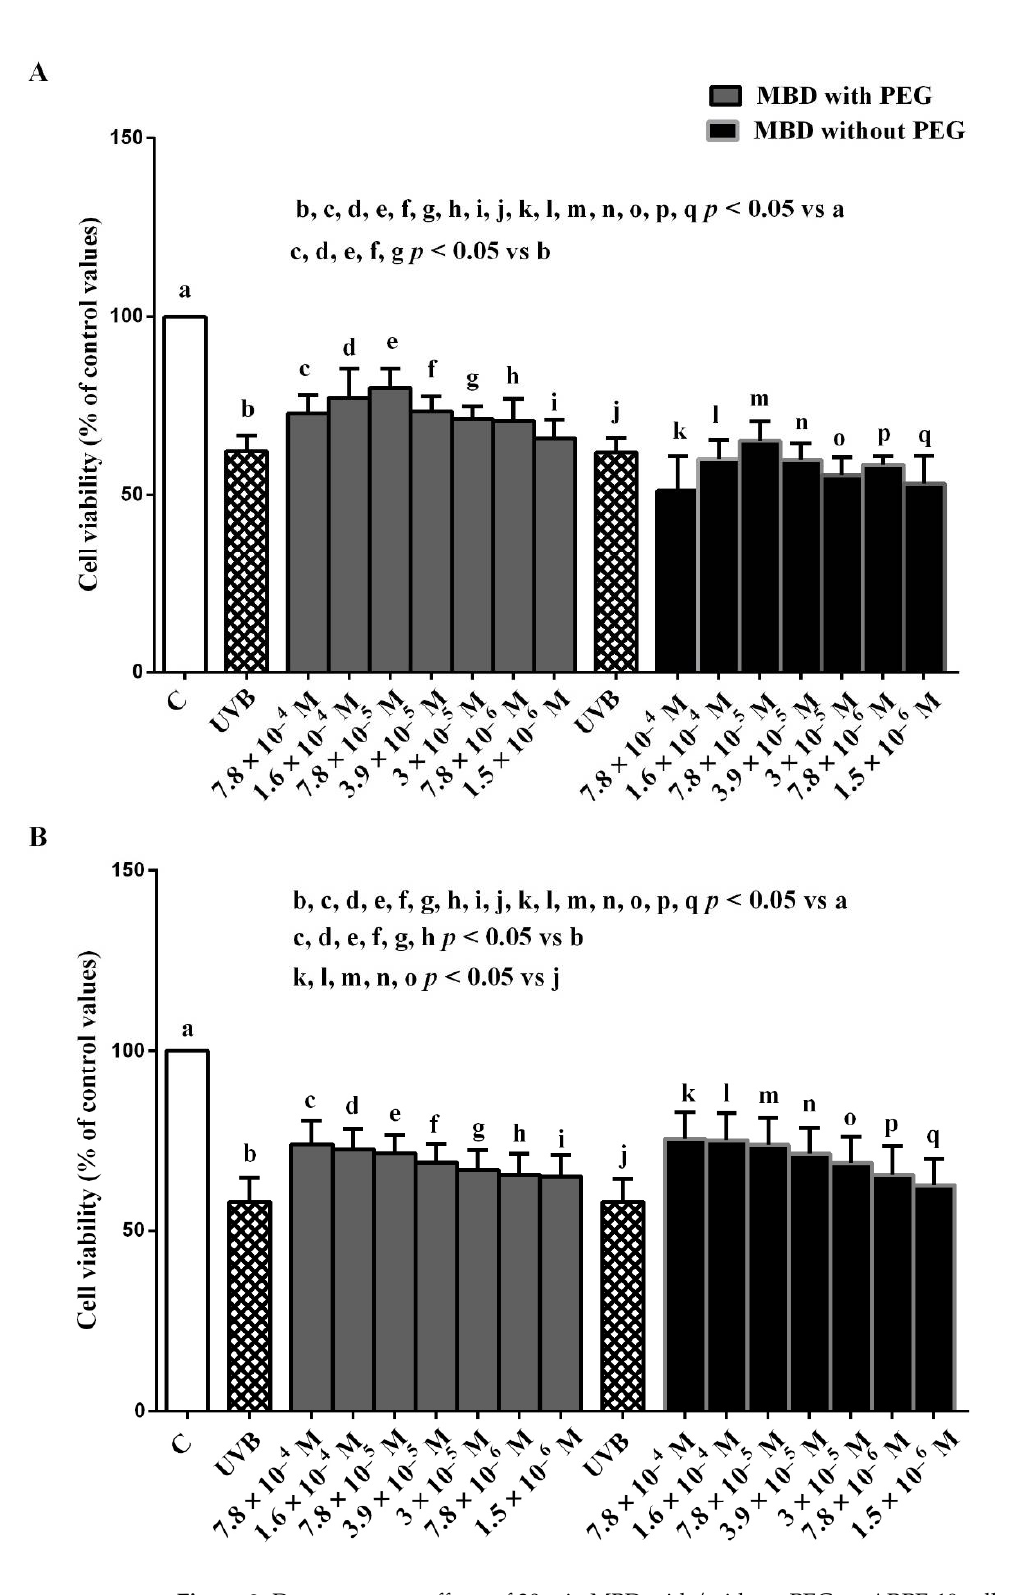
Figure 3. Dose–response effects of 30 min MBD with/without PEG on ARPE-19 cells ( A ) and RGC-5 cells ( B ) in the presence of UVB (0.117 J/cm 2 for 30 min). The results are means ± SD of repeated experiments. C: control cells (non-treated).